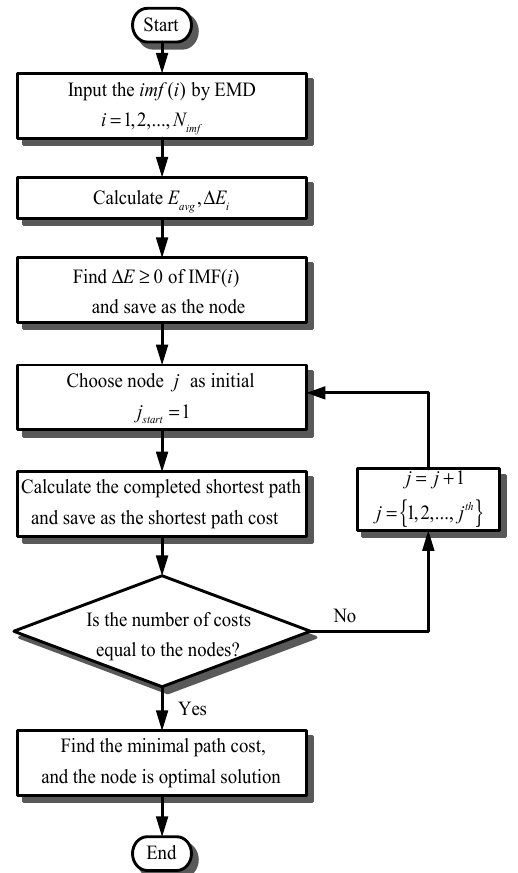
Figure 5. Optimization of intrinsic mode functions (IMFs) by using the proposed GEMD model.